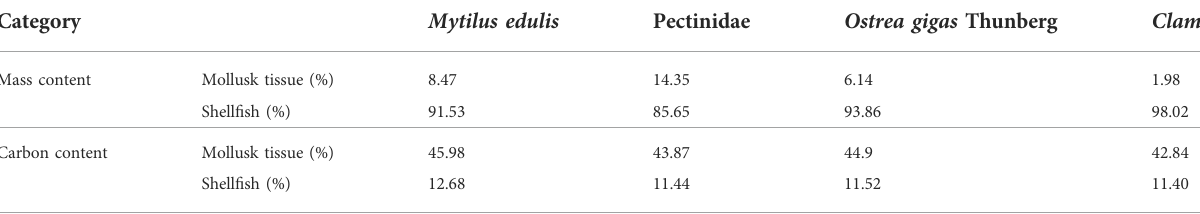
TABLE 2 Mass and carbon content within mollusk tissue and shell fi sh following Yue and Wang (2012). Category